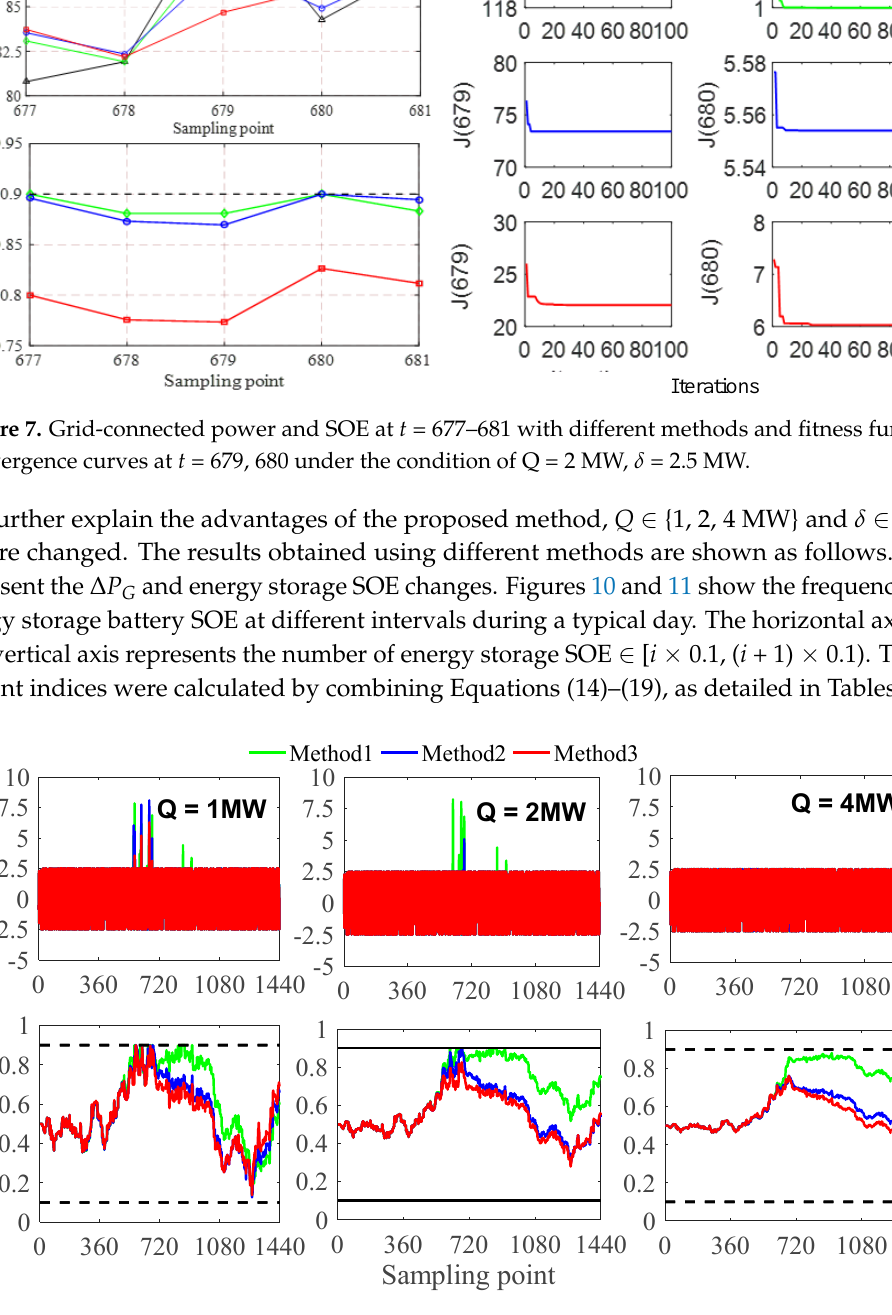
Figure 9. Comparison curve of Δ P G and SOE with three methods under different δ . Table 4. Assessment criteria under different Q. Energy Storage Battery Capacity